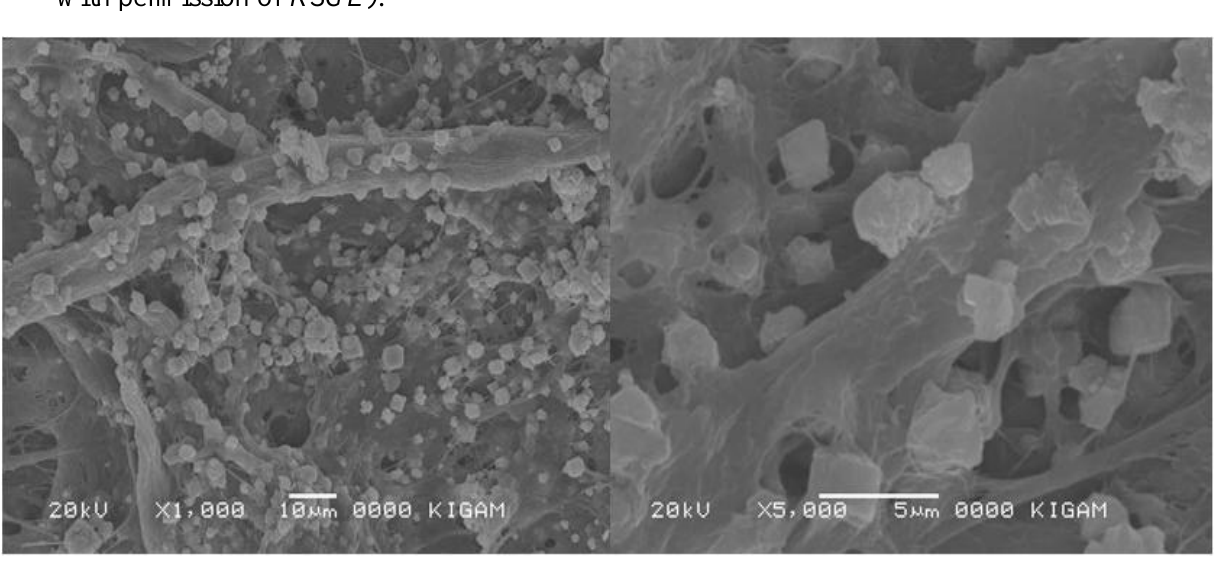
Figure 23. Scanning electronic microscope (SEM) image of microstructure of the recycled paper made from waste pulp (old newspaper) through in-situ process with PCC (10% calcite): PCC filler shows high adhesion to the surface of the pulp (from Ahn et al ., [66] with permission of KSGE